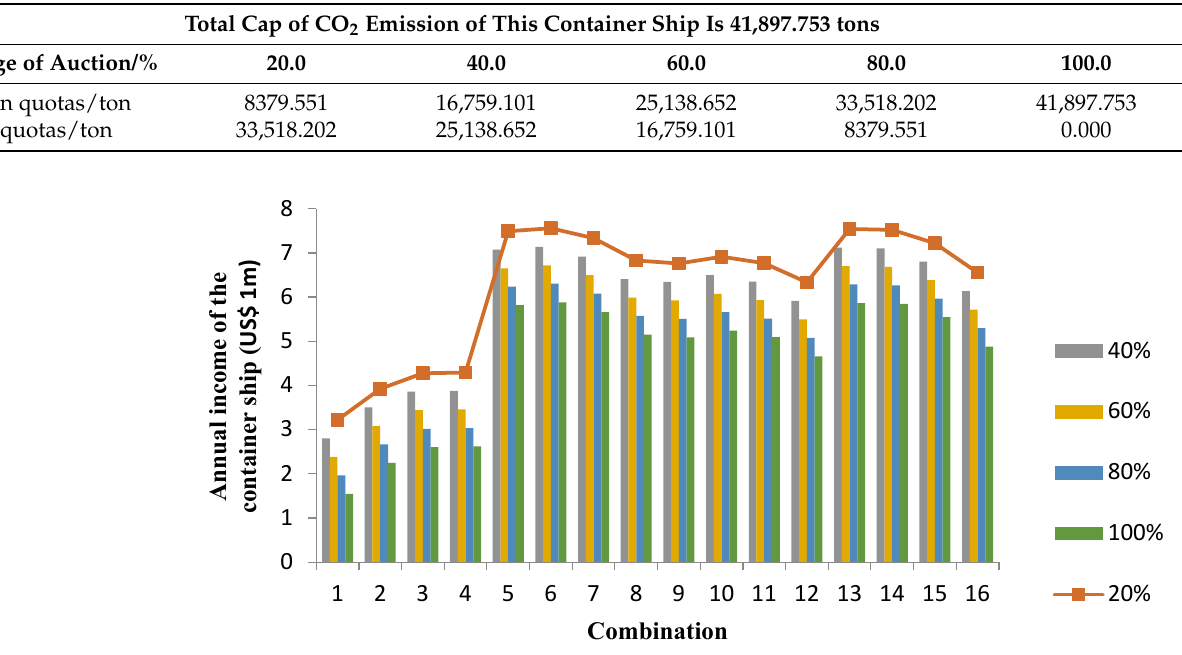
Figure 2. Annual income of the container ship with different combinations of CO 2 emission reduction measures in 2030.